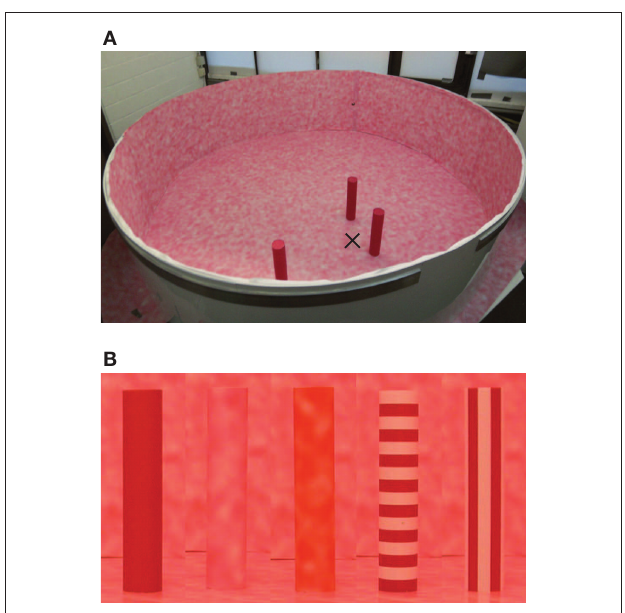
Figure 1 | Honeybee flight arena. (A) Bees were trained to visit a perspex feeder (indicated by a black cross) surrounded by three landmarks (diameter of 5 cm, height of 25 cm) placed at different distances (10, 20, 40 cm) from the feeder. The circular flight arena (diameter of 1.95 m; height of 50 cm) was covered with a white curtain (removed for the picture), and indirect illumination was provided by artificial light sources positioned above and symmetrically around the arena. The arena floor and wall was covered with a random dot texture (see Materials and Methods for details). (B) Photographs of landmark cylinders covered with the five different label textures are shown (homogenous red, random dot, high-contrast random dot, horizontal and vertical stripe patterns). The landmark closest to the feeder seen in the right of picture (A) was labeled by such a